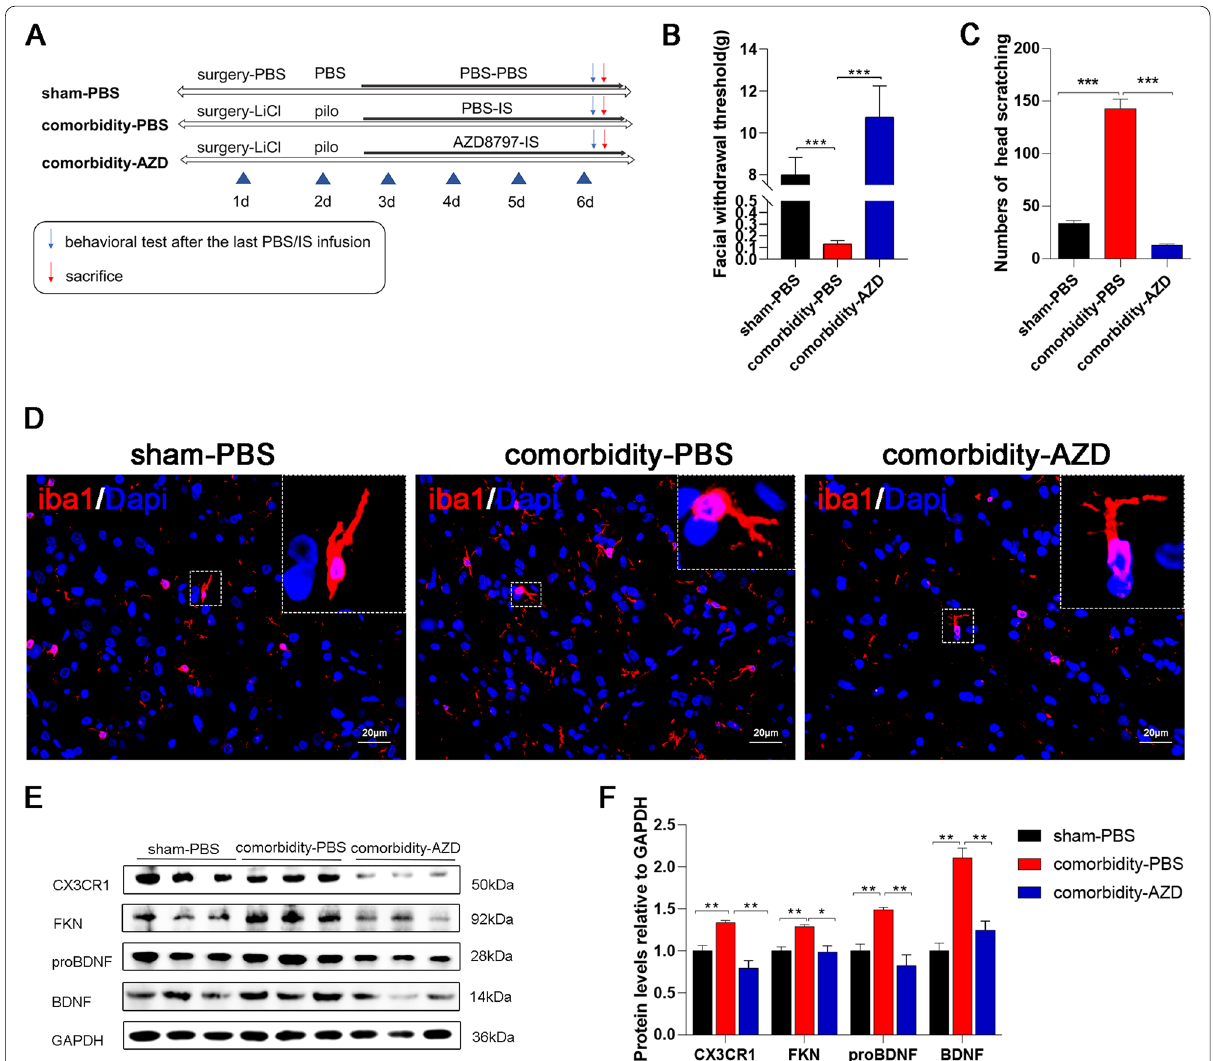
Fig. 5 AZD8797 treatment attenuates SE-induced increases in nociceptive behaviour, microglial activation, and protein changes. A Flow chart of the experimental groups: sham-PBS, comorbidity-PBS, and comorbidity-AZD. B Mechanical threshold in the comorbidity-PBS group was decreased compared to that in the sham-PBS group and was reversed in the comorbidity-AZD group. Mean SEM; one-way ANOVA; n 6 rats per group; ± = *** P < 0.001. C Head-scratching counts were increased in the comorbidity-PBS group compared to the sham-PBS group, and were restored after AZD8797 treatment. Mean SEM; one-way ANOVA; n 6 rats per group; *** P < 0.001. D Immunofluorescence staining of iba1 showing that ± = AZD8797 reversed epileptic microglial activation and hyperplasia. Scale bar 20 μm. The white box was enlarged. E Representative western blot = images showing CX3CR1/FKN/proBDNF/BDNF/iba1 protein expression in the sp5c of the different groups. F Quantification of proBDNF and BDNF protein levels in the sham-PBS group, comorbidity-PBS group, and comorbidity-AZD group. Mean SEM; one-way ANOVA; n 3 rats per group; ± = * P < 0.05, ** P <